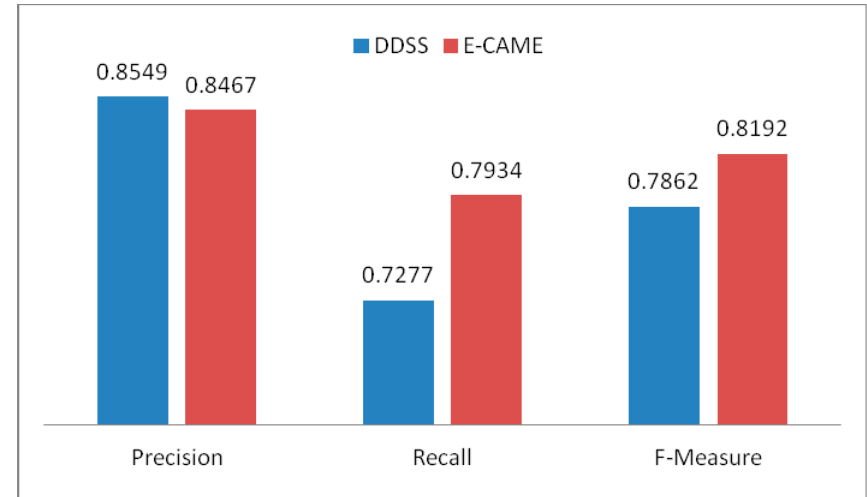
Figure 10. Average results in terms of Precision, Recall, and F-Measure of the proposed system and Extended CAME (E-CAME) [19] for a set of 36 experiments.